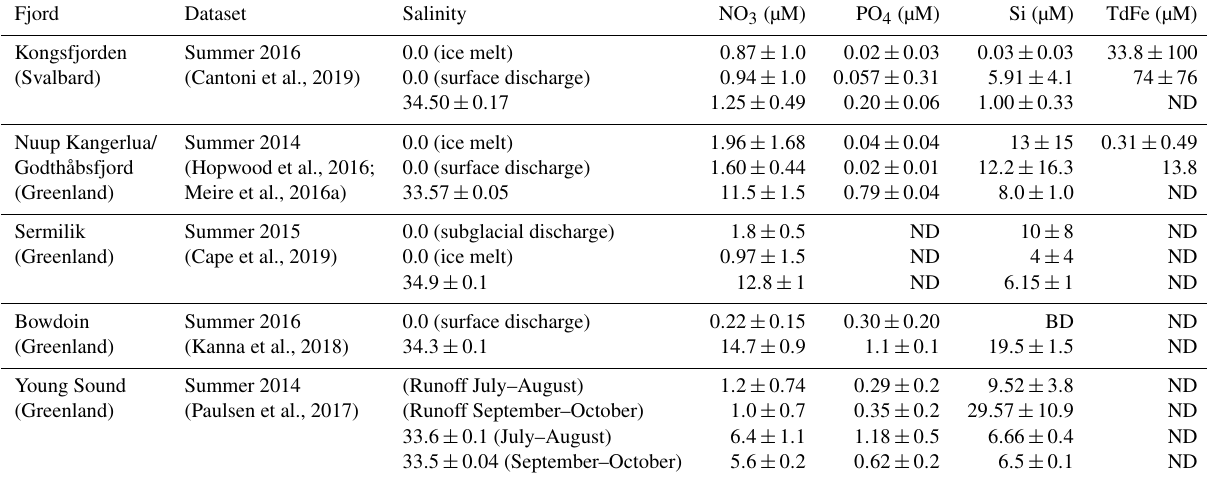
Table 2. Measured/computed discharge and saline endmembers for well-studied Arctic fjords (ND, not determined/not reported; BD, below